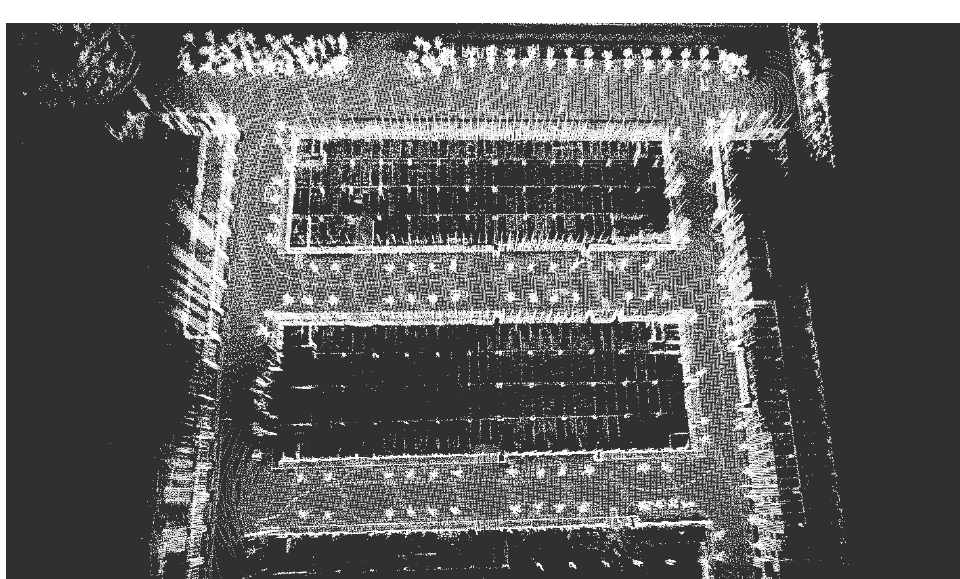
Figure 8. High-precision maps recorded using tracked vehicles equipped with 64-line